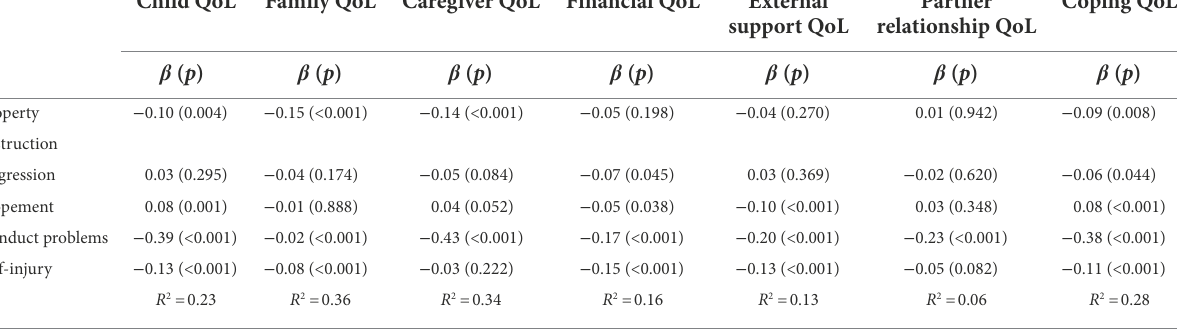
TABLE 2 Standardized path coefficients from challenging behavior subscales to quality of life